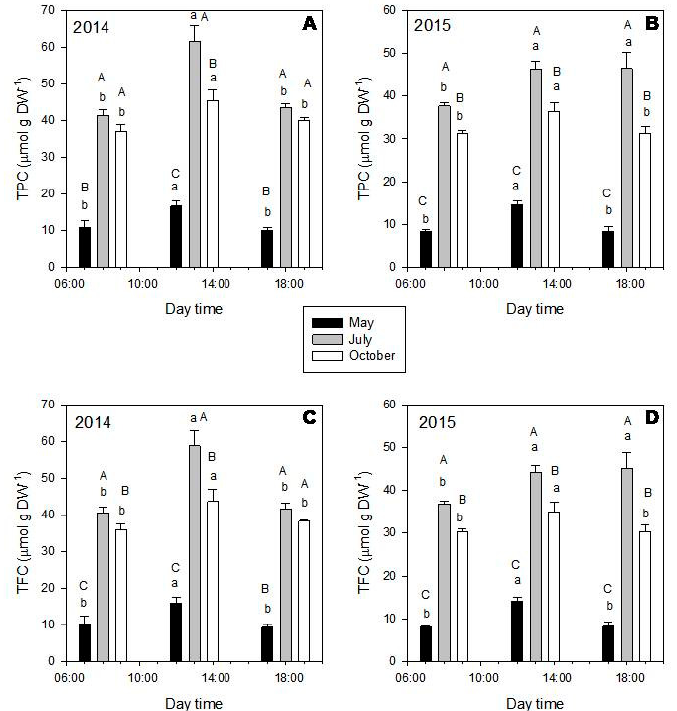
Figure 4. Total phenolic (TPC—upper graphics) and total flavonoid contents (TFC—down graphics) of Phillyrea latifolia extracts of leaves harvested in 2014 (left) and 2015 (right), during the different months (May—black bars; July—gray bars; October—white bars) and day times (8:00; 13:00, and 18:00). Mean values ± SD in μ mol gDW -1 (n=3). Data was analyzed by two-way ANOVA test, with Tukey post-test, after variance homogeneity analysis by Levene’s test and normality analysis by Shapiro–Wilk test. Equal capital letters indicate no statistical differences between the monthly results (at the same time) and lowercase letters indicate no statistical differences between daily results (inside the same month) ( p ≤ 0.05). Harvesting time and month had also a significant effect in leaf phenolics of C. incanus ( p < 0.001, Table S2, Figure 5 and 6). For this species, each class of polyphenols showed a different seasonal